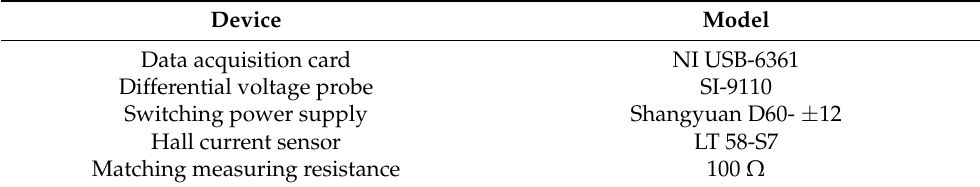
Table 2. Devices model.